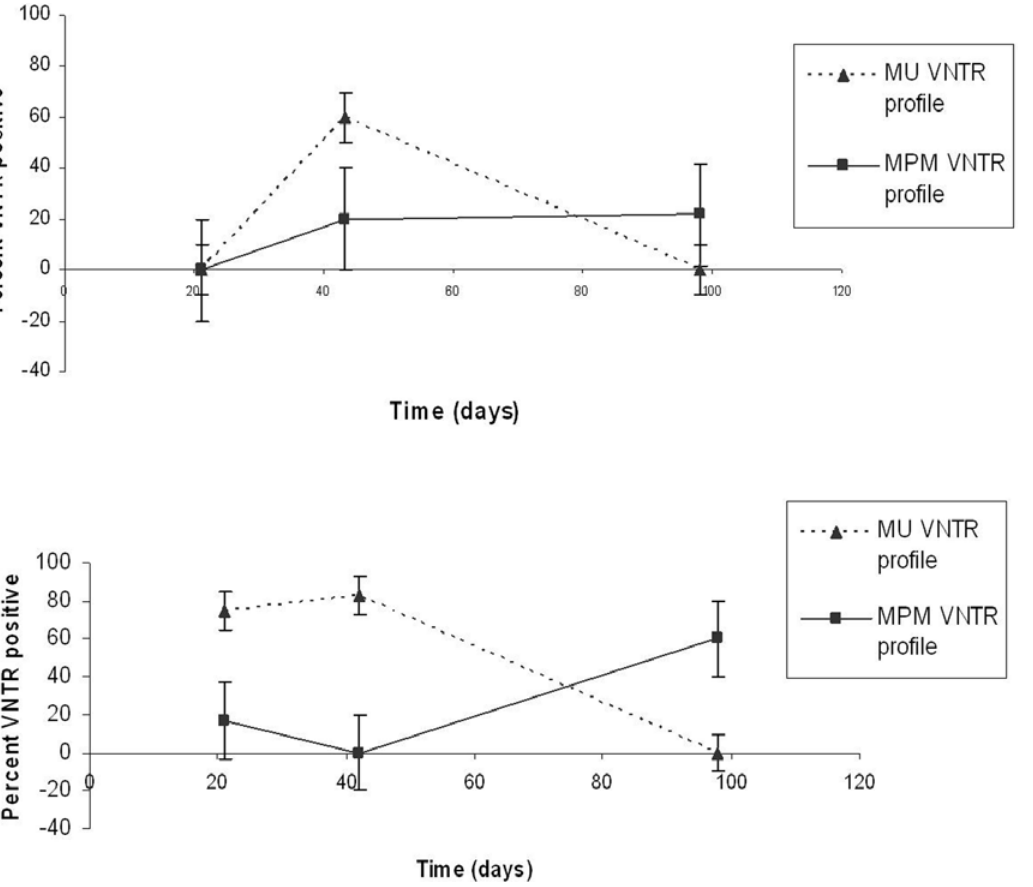
Figure 5. A timecourse of VNTR profiles of M.ulcerans or other mycolactone producing mycobacteria from biofilm slide samples collected from a Buruli ulcer endemic and non-endemic aquatic site. (Top) Percent of ER-positive biofilm slides with M. ulcerans or MPM VNTR profiles at 21d, 42, and 98d from A-Adigon (non-endemic). (Bottom) Percent ER-positive biofilm slides collected at 21d, 42d, and 98d from Amasaman (endemic).